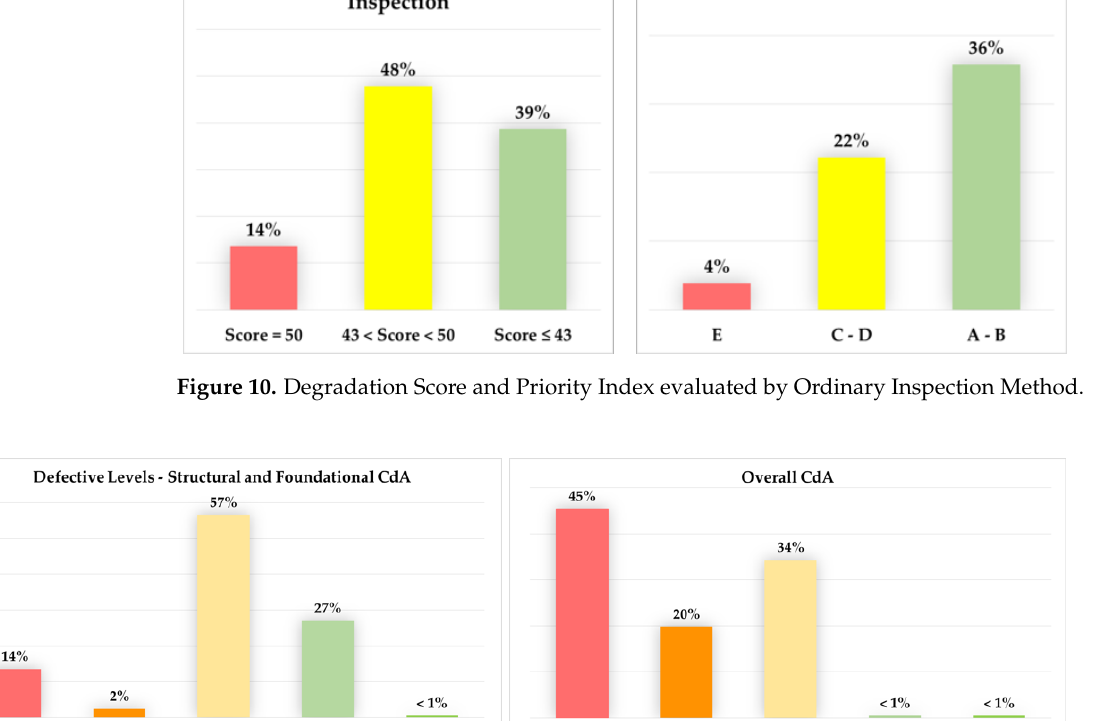
Figure 10. Degradation Score and Priority Index evaluated by Ordinary Inspection Method.